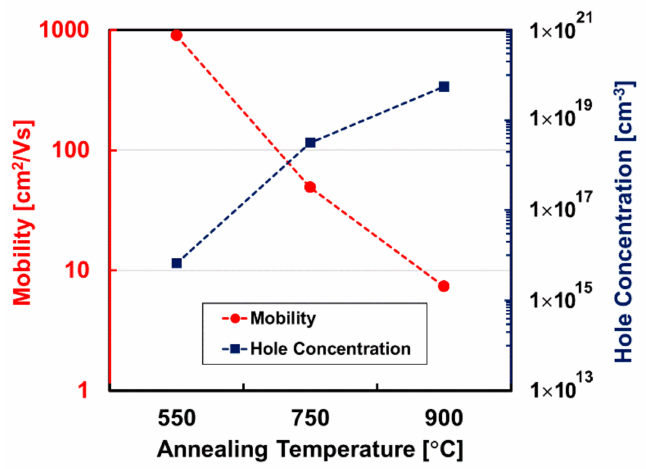
Figure 10. Variation of the hole concentration (blue) and mobility (red) with thermal annealing